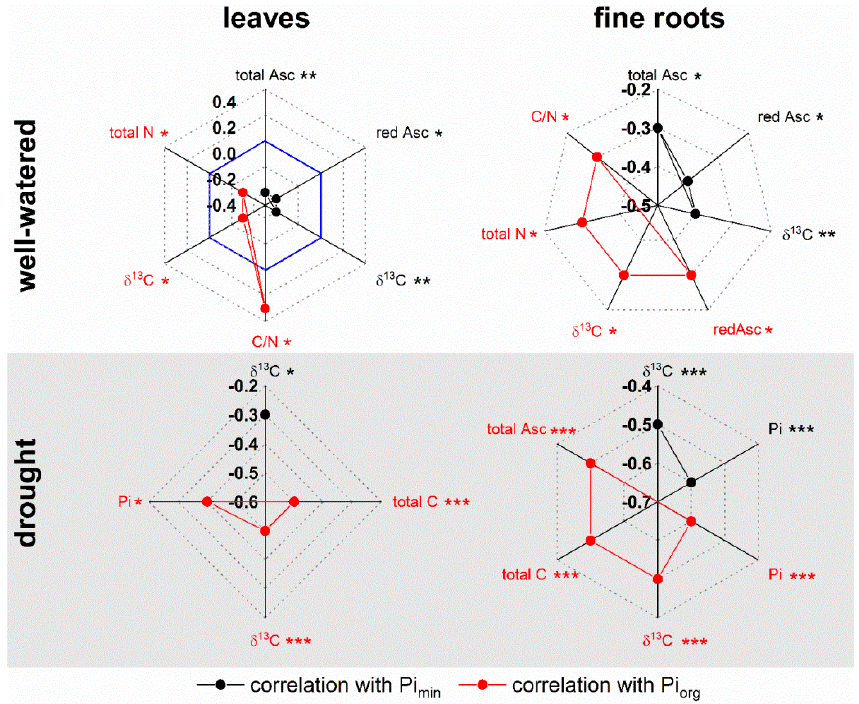
Figure 2. Correlation of physiological parameters in leaves (left) and fine roots (right) with P i and Pi org in the soil in the habitat of origin in well-watered (top) as well as drought-treated beech saplings. The diagrams show the parameters determined in leaves and fine roots and their dependencies on Pi min (black filled circles) and Pi org (red filled circles) in the soil of the respective habitats of 10 Croatian beech forest stands under well-watered conditions (white background) and the drought treatment (grey background). X-axes show Pearson’s correlation coefficients. * p ≤ 0.05; ** p ≤ 0.01; *** p ≤ 0.001. Zero lines are given in